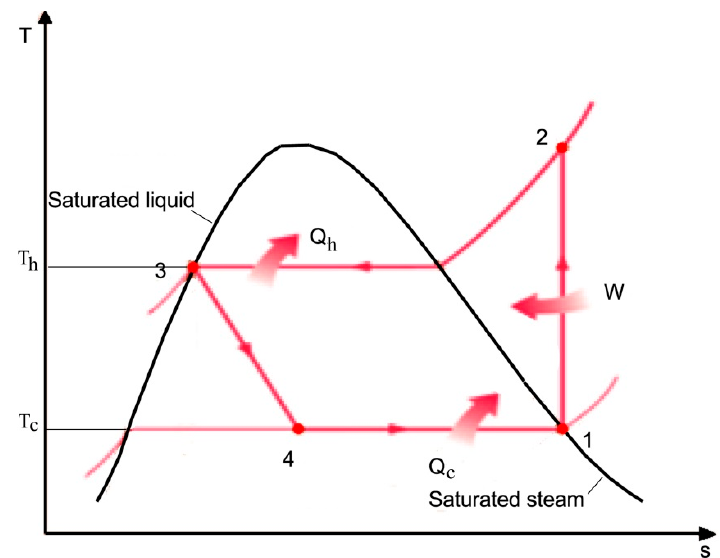
Figure 1. Refrigeration cycle represented on the entropy ‐ temperature plan (s ‐ T): 1–2 compressor; 2–3 condenser; 3–4 expansion valve; 4–1 evaporator.